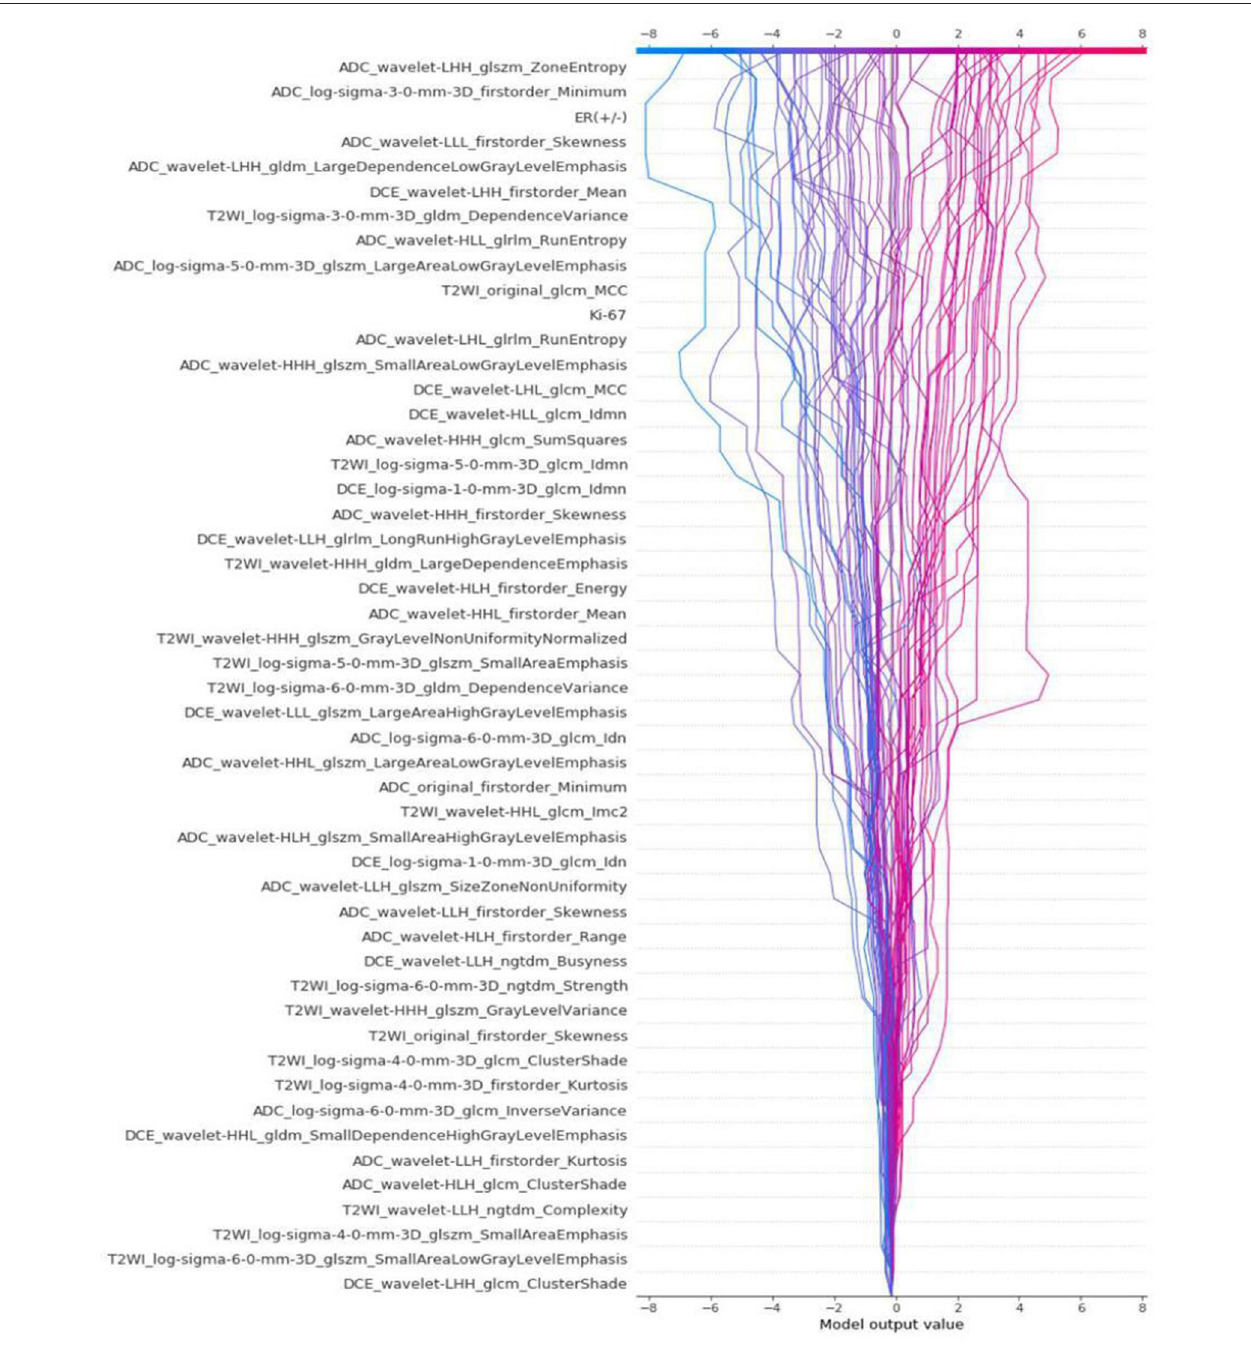
FIGURE 9 | The decision curve that reflects how each feature affects the predictive output for the patients in testing dataset by classical splitting with a ratio of